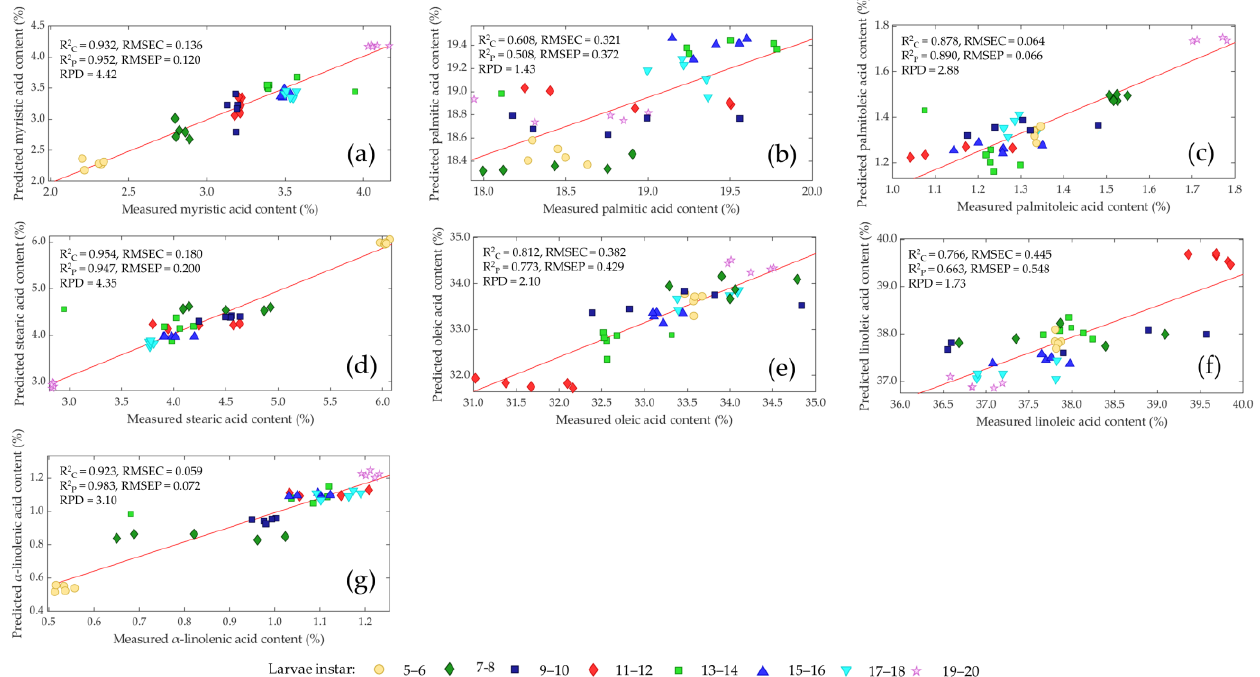
Figure 6. Comparison of measured and predicted values of myristic acid ( a ), palmitic acid ( b ), palmitoleic acid ( c ), stearic acid ( d ), oleic acid ( e ), linoleic acid ( f ) and α -linoleic acid ( g ) of living meal- worm larvae with different instars ( • 5 – 6, 7 – 8, ◼ 9 – 10, 11 – 12, ◼ 13 – 14, 15 – 16, 17 – 18, 19 – 20) in validation sets by near-infrared spectroscopy.